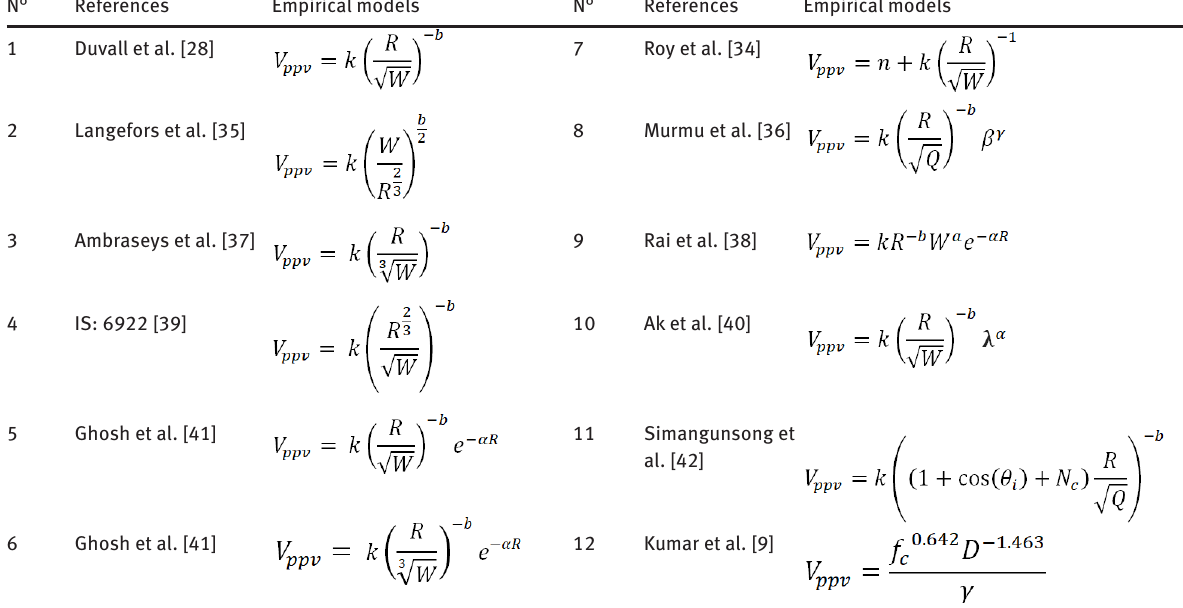
Table 1: Summary of various PPV models.